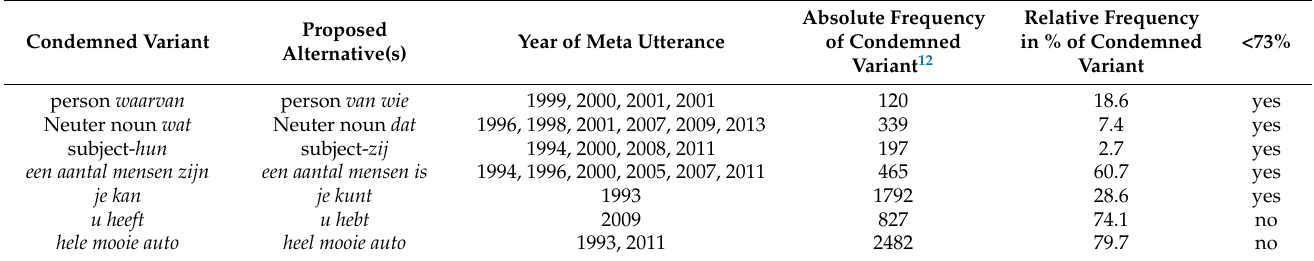
Table 9. Grammatical usage items with year(s) of prescriptive utterance, absolute and relative frequency counts of condemned variant in usage, and evaluation with regard to Frequency